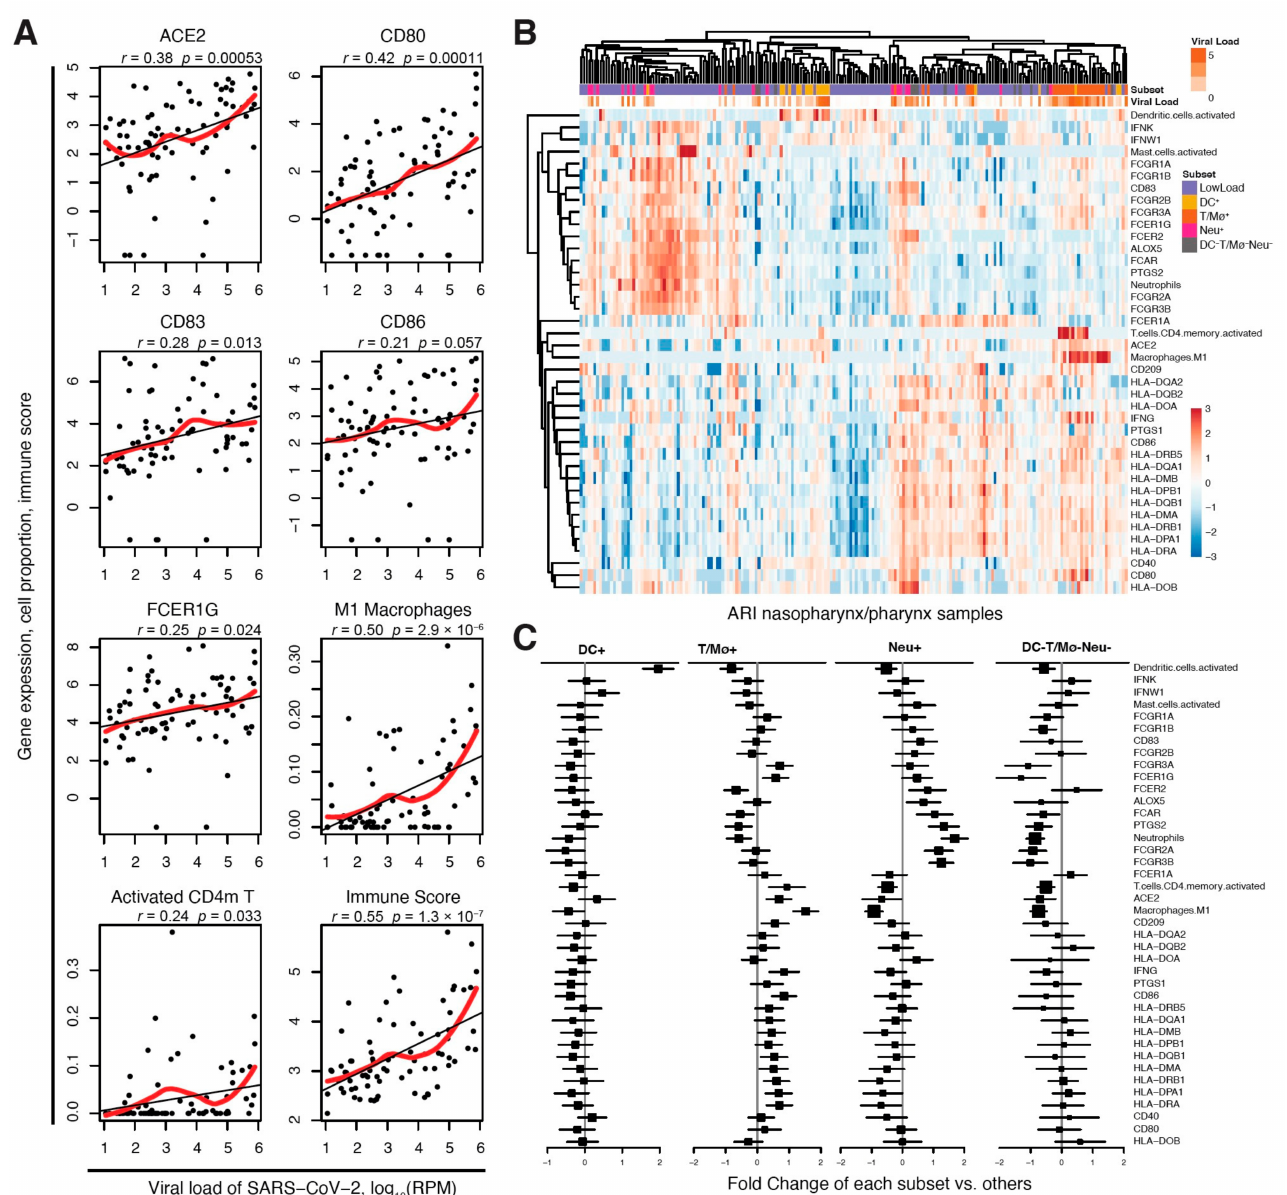
Figure 2. Correlation and variation of SARS-CoV-2 receptors and immune factors in nasopharynx/pharynx samples of SARS-CoV-2 ARIs. ( A ) Scatter plots of SARS-Cov-2 viral load against gene expression profiles of SARS-CoV-2 receptor ACE2, immune response activators (CD80, CD83 and CD86), FCER1G, the proportion of active CD4 memory T cells and M1 macrophages in 22 immune cell types, as well as scores from a linear model of 5 immune cell types (active CD4 memory T cells, M1 Mø, mast cells, neutrophils and active DCs). The black and red lines are fits of linear model and LOESS, respectively. ( B ) Hierarchical clustering and heatmap of SARS-CoV-2 receptors, immune factors and proportions of 5 immune cell types in ARI samples. Five subsets of ARI samples were identified, including 1 subset with low SARS-CoV-2 load (LowLoad) and 4 subsets with high SARS-CoV-2 load and activated DCs (DC + ), activated T cells or M1 Mø (T/Mø + ), activated neutrophiles (Neu + ) and no activation of any of those cell types (DC − T/Mø − Neu − ). For each feature, red indicates relatively higher value and blue indicates relatively lower value across samples. The scale corresponds to the relative value across samples. ( C ) The fold changes of each feature comparing each subset to others. 95% confidence intervals are shown as bars. The size of the squares is proportional to the standard